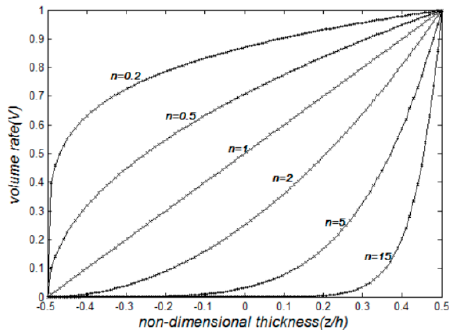
Figure 2. Volume ratio with thickness of the FGM plate.